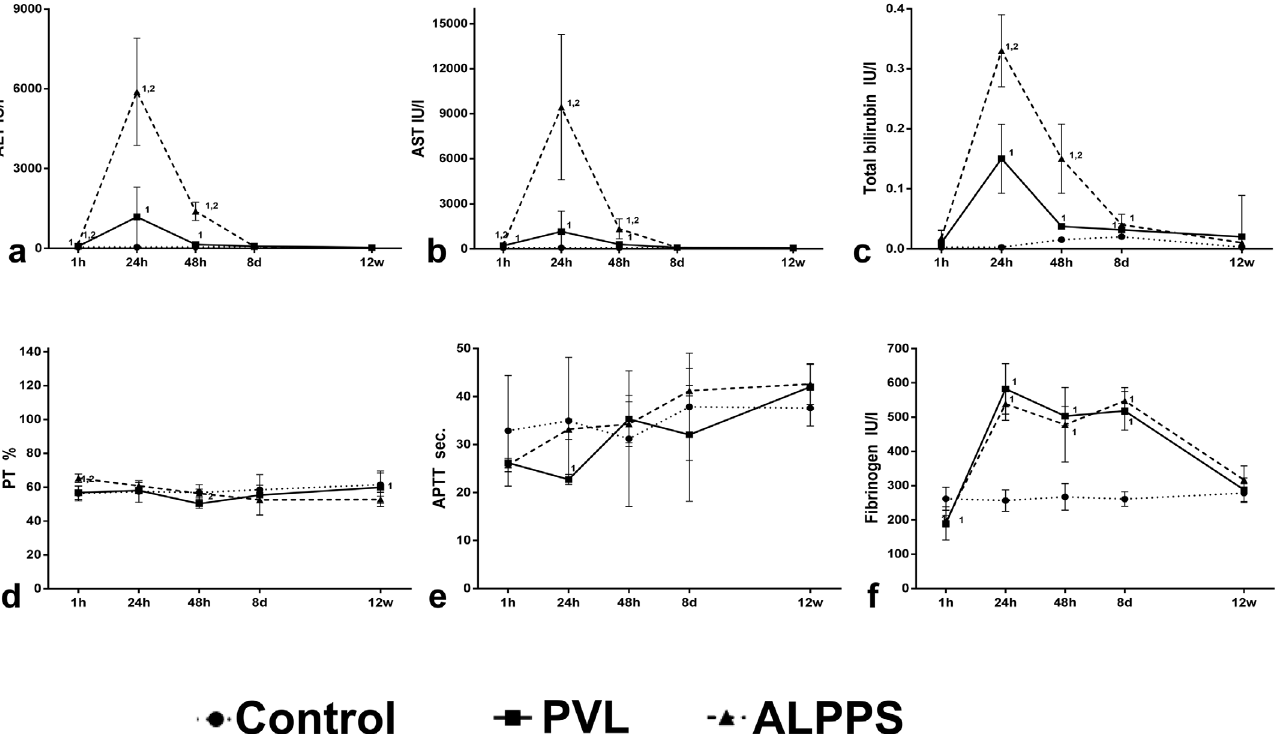
Fig 6. Levels of serum ALT, AST, total bilirubin, PT, APTT and fibrinogen from serum samples from control, PVL and ALPPS groups. The degree of hepatic damage induced by the first step of the ALPPS procedure was evidenced by serum levels of ( a ) ALT, ( b ) AST and ( c ) total bilirubin was significantly higher in ALPPS group in comparison with PVL. In contrast, there were no differences in ( d ) PT, ( e ) APTT and ( f ) fibrinogen levels. Mann-Whitney U test (n = 6 animals per group). The numbers (1, 2) indicate significant differences of the considered group in comparison with control (1) and PVL (2) groups, respectively. A p value of < 0.05 was considered as